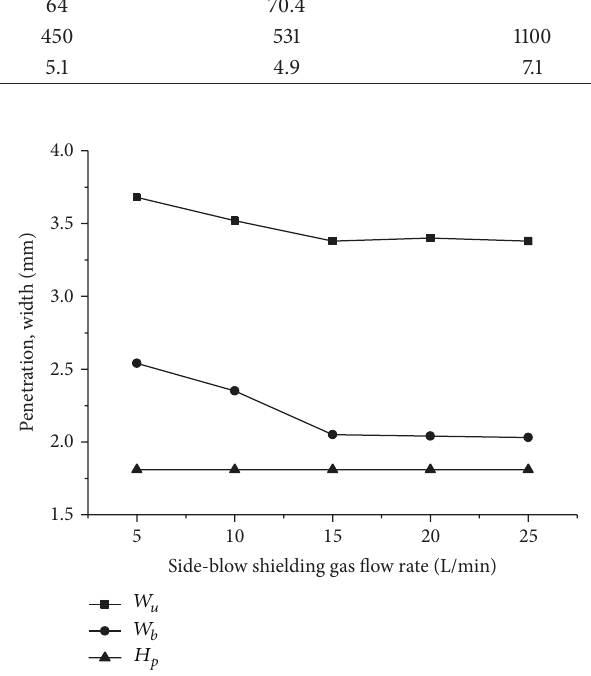
Figure 6: Influence of defocus amount on width and penetration of